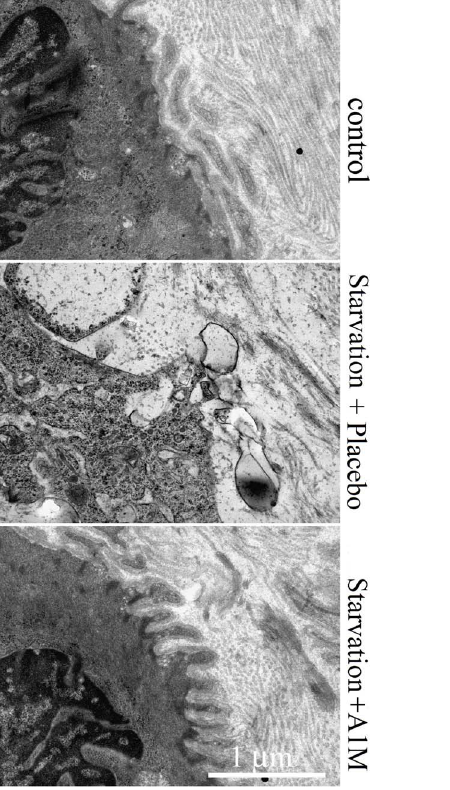
Figure 6. Placental ultra-stucture visualized by transmission electron microscopy. Ultra-structure of placental tissue visualized by transmission electron microscopy. The structure in ultra-thin sections of starved placebo (middle) and starved A1M treated (bottom) animals was compared to the control animals (top).